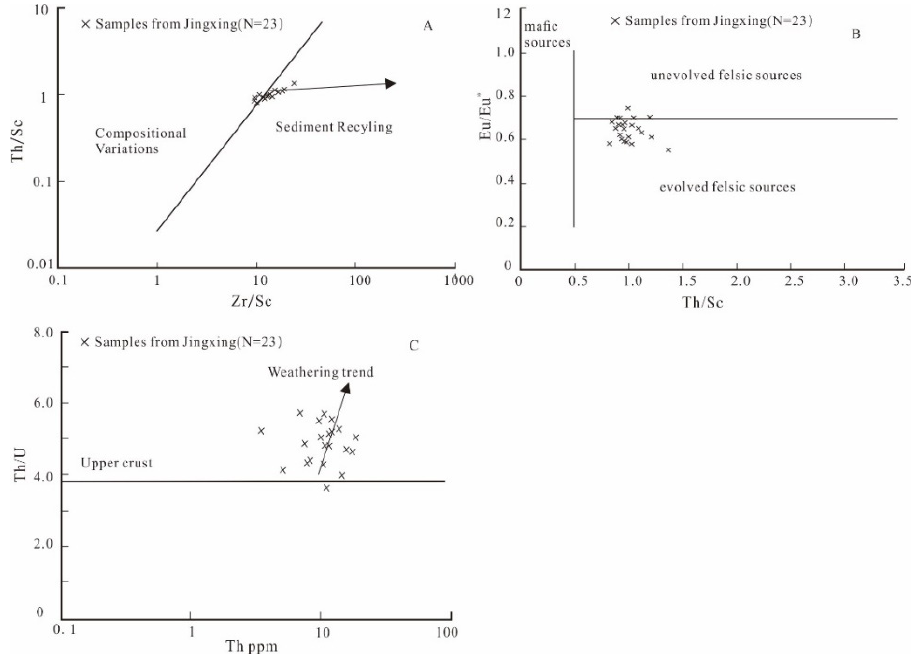
Figure 8. Discrimination diagrams illustrating sedimentary provenance. ( A ) Th/Sc versus Zr/Sc plot of samples (after McLennan et al., 1993 [58]). ( B ) Eu/Eu* versus Th/Sc of samples. (after McLennan et al., 1990 [66]). ( C ) Th/U versus Th, showing samples derived from felsic sources (after McLennan et al., 1993 [58]).